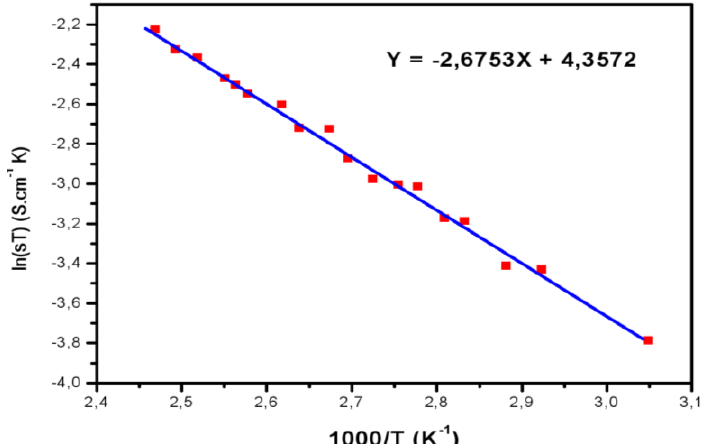
Figure 6: Arrhenius plot of the electrical conductivity of [3-(CH